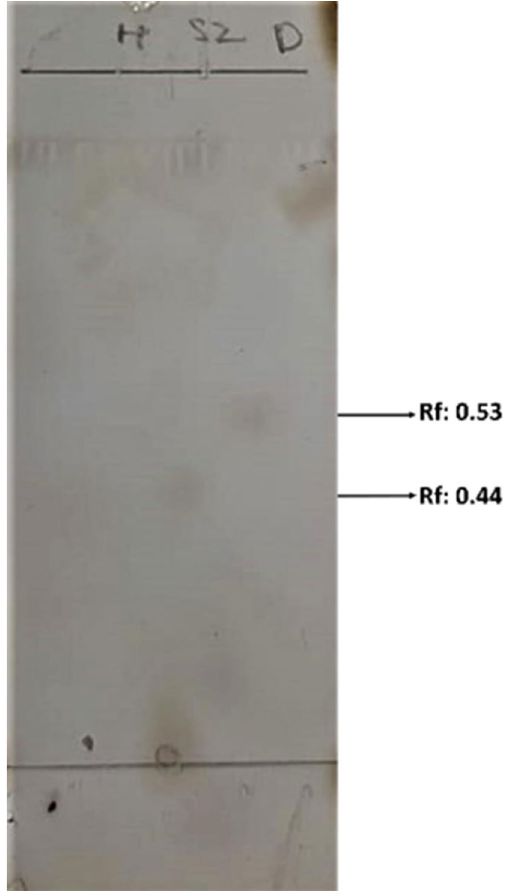
Figure 9. TLC chromatogram of acid-hydrolysed exopolysaccharide from Nitzschia palea ; showing two different black spots of oligosaccharides derived from the exopolysaccharide of the diatom due to after acid